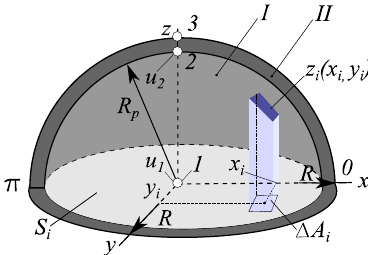
Fig. 4. Stiffness integration scheme hemisphere with the matrix film, where: I – particle; II – matrix